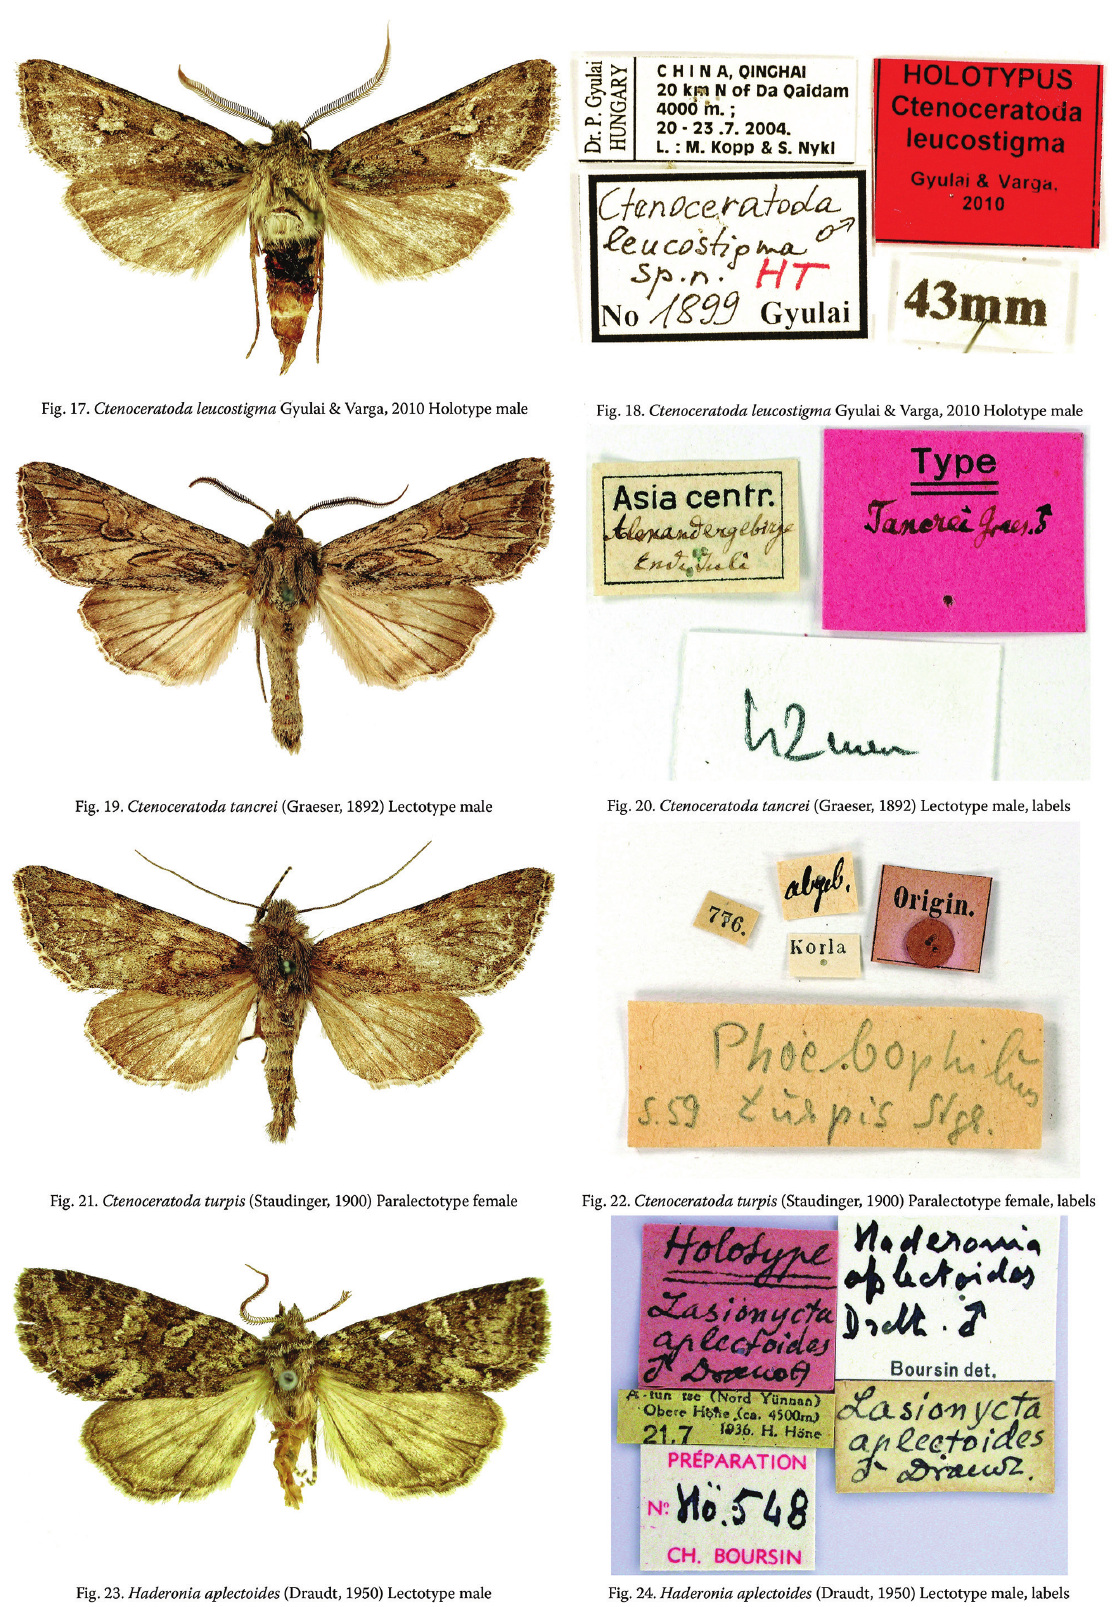
Figure 17–24. 17. Ctenoceratoda leucostigma Gyulai & Varga, 2010 Holotype male. 18. Ctenoceratoda leucostigma Gyulai and Varga, 2010 Holotype male, labels. 19. Ctenoceratoda tancrei (Graeser, 1892) Lectotype male. 20. Ctenoceratoda tancrei (Graes- er, 1892) Lectotype male, labels. 21. Ctenoceratoda turpis (Staudinger, 1900) Paralectotype female. 22. Ctenoceratoda turpis (Staudinger, 1900) Paralectotype female, labels. 23. Haderonia aplectoides (Draudt, 1950) Lectotype male. 24. Haderonia aplectoi- des (Draudt, 1950) Lectotype male,